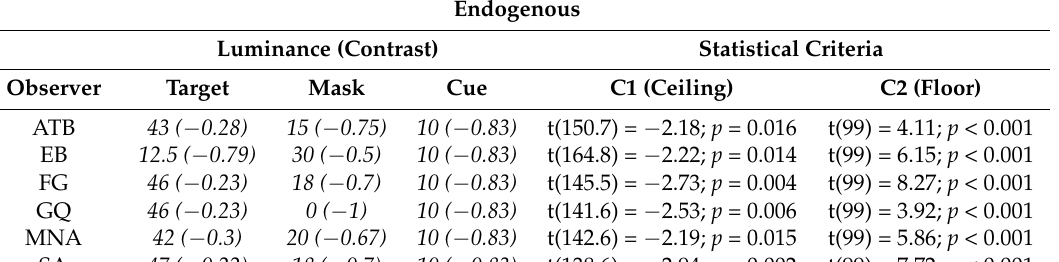
Table 1. The target, mask, and cue luminance values in cd/m 2 (and corresponding Weber contrast values) are listed for each observer in endogenous and exogenous attention conditions. The background luminance was 60 cd/m 2 for all observers. The results of t -tests used to assess whether criteria C1 and C2 are met are also listed for each observer. Note that we used two-sample t -tests with unequal variances for testing for criterion C1, and one-sample t -tests against chance level (0.5) for testing for criterion